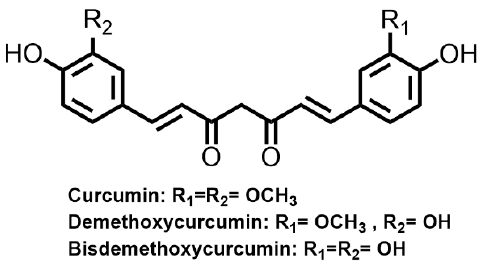
13 of 21 Figure 5. Molecular structures of indigo, indigo carmine and the pH effect on the soluble forms of indigos. 3.5. Curcuminoids Curcuminoids are a bis- α , β -unsaturated diketone and in solution exist in equilib- rium with the corresponding enol tautomer [11]. They are abundant in the rhizome of Curcuma longa (turmeric) and can be found in other Zingiberaceae and Araceae families. Under acidic and neutral conditions, the bis-keto form predominates, whereas at > pH 8